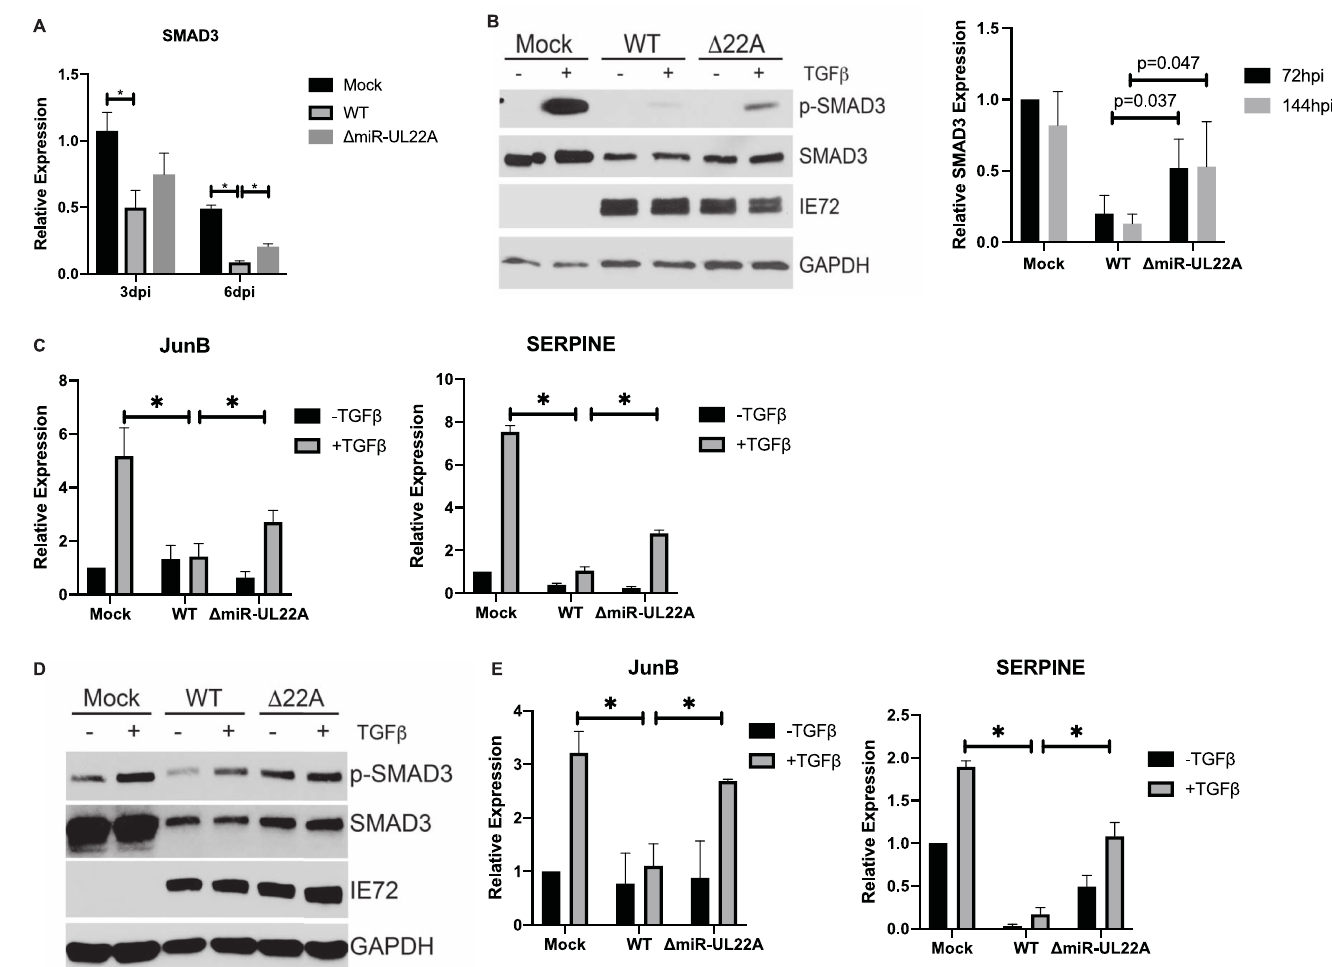
Fig 2. miR-UL22A targets SMAD3 during lytic infection. (A) NHDF were infected for 3 or 6 days with the indicated virus and then RNA was isolated and subjected to qRT-PCR for SMAD3. Experiments were performed in triplicate. NHDF (B) or hAEC (D) were infected with the indicated viruses for 48 hours followed by overnight serum starvation and stimulation with TGF β (100pg/mL) for 4 hours. Protein lysates were subjected to immunoblotting using the indicated antibodies. Western blot quantification of SMAD3 levels from 4 independent experiments in (B) was performed using ImageJ analysis software. NHDF (C) or hAEC (E) were infected as in (B) and RNA was isolated followed by qRT-PCR for JunB or SERPINE. Experiments were performed in triplicate. � p < 0.05 by two tailed Student’s t test.